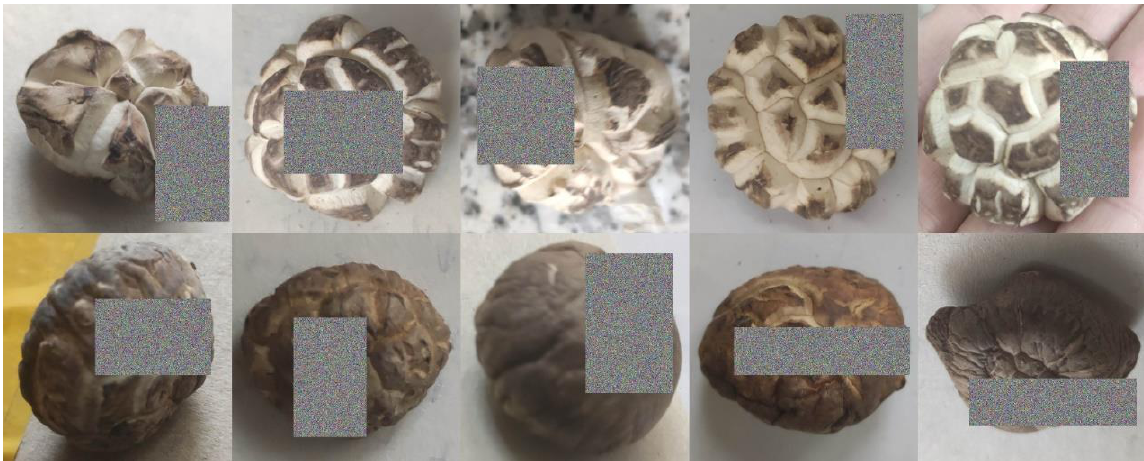
Figure 5. Shiitake mushroom images after Random Erasing.